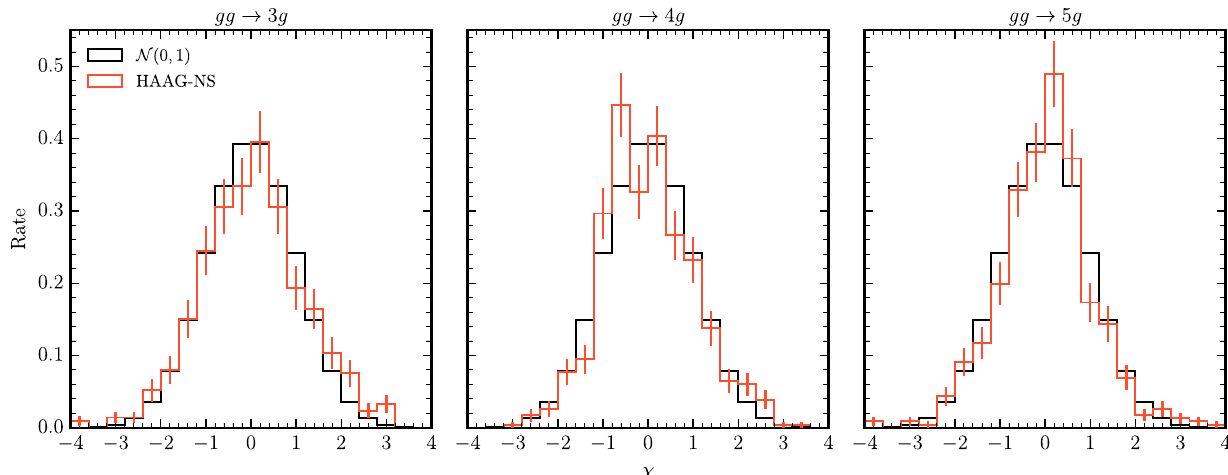
Fig. 4 Global rate of occurrence of per bin deviation, χ , between H AAG and NS, for each considered scattering process. A normally distributed equivalent deviation rate is shown for